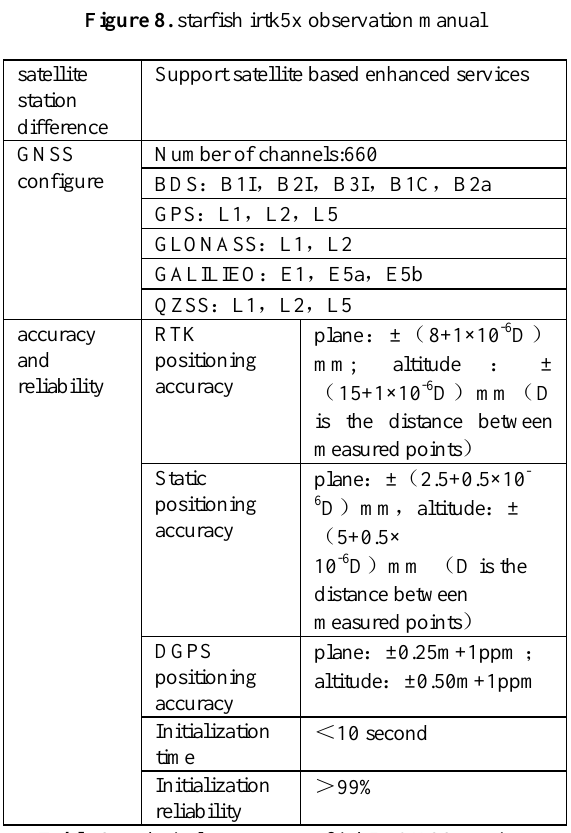
Table 2. technical parameters of irtk5x GNSS